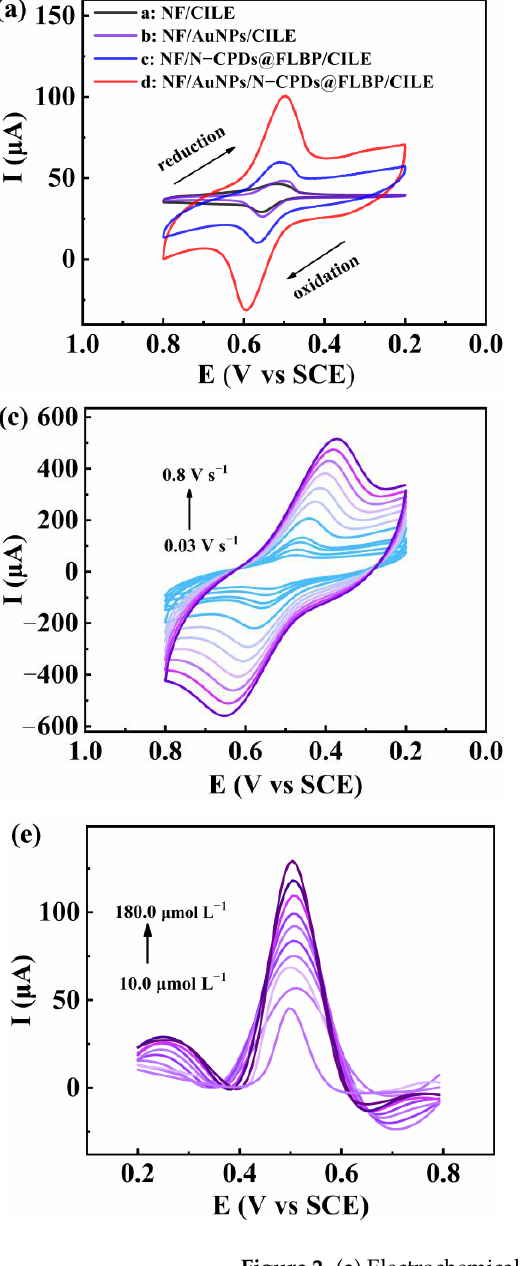
Figure 2. ( a ) Electrochemical behavior of 20.0 µ mol L − 1 rutin with different modified electrodes (scan rate: 0.1 V s − 1 ); ( b ) the effects of different pH (1.5, 2.0, 3.0, 4.0, 5.0, 6.0) on oxidation peak potentials and oxidation peak currents for rutin on NF/AuNPs/N-CPDs@FLBP/CILE in 0.1 mol L − 1 PBS; ( c ) CV curves of 20.0 µ mol L − 1 rutin on NF/AuNPs/N-CPDs@FLBP/CILE at different scan rates (0.03, 0.05, 0.08, 0.1, 0.2, 0.3, 0.4, 0.5, 0.6, 0.7, and 0.8 V s − 1 ); DPV curves of rutin with NF/AuNPs/N- CPDs@FLBP/CILE in 0.1 mol L − 1 PBS containing rutin concentrations from ( d ) 0.01 µ mol L − 1 to 10.0 µ mol L − 1 and ( e ) 10.0 µ mol L − 1 to 180.0 µ mol L − 1 ; ( f ) the linear relationship between I pa and concentration of rutin (inset: The linear relationship from 0.01 µ mol L − 1 to 10.0 µ mol L − 1 ). The electrochemical behavior of 20.0 µ mol L − 1 rutin on NF/AuNPs/N-CPDs@FLBP/ CILE was evaluated in detail. The influence of PBS pH from 1.5 to 6.0 was explored by CV (Figure 2b). The oxidation peak potential (E pa ) of rutin shows a downward trend linearly with increasing pH, which confirms the participation of protons directly in the oxidation process of rutin. On top of this, the linear equation of E pa (V) = 0.657 − 0.0525